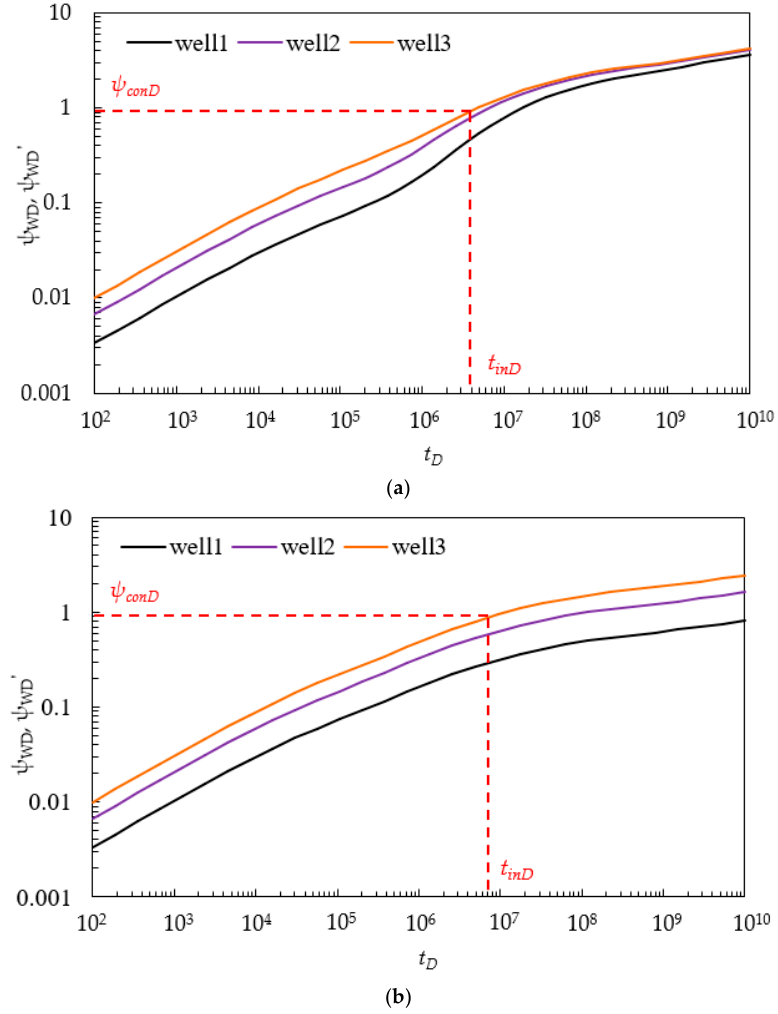
Figure 12. Illustration of pressure build-up curve ( q 1 : q 2 : q 3 = 1:2:3), P con = 7 MPa: ( a ) MWPs scheme, Figure 2b, Case 3; ( b ) SMFHWs. Table 2. Comparison between MWPs, SMFHWs, and numerical results.